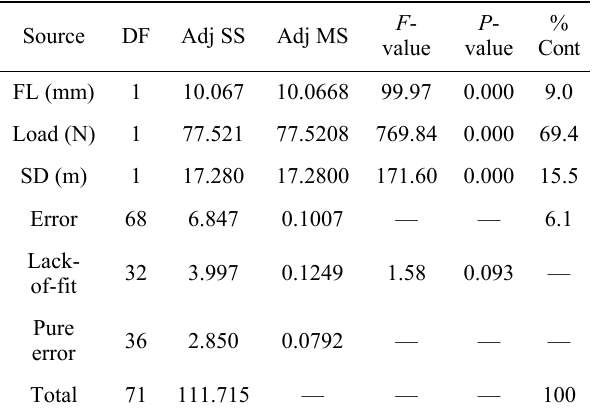
Table 7 Analysis of variance for the amount of wear.